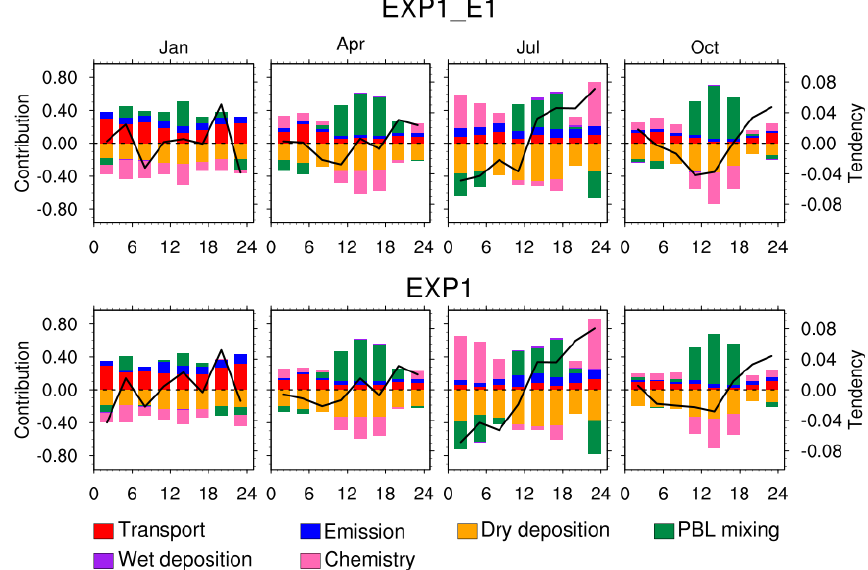
Figure 15. Relative contribution (normalized by monthly mean surface PM 2 . 5 concentrations for each month) to surface PM 2 . 5 concen- trations every 3h from individual processes (transport, emission, dry and wet deposition, PBL mixing, chemical production/loss) averaged over southern Anhui for January, April, July, and October of 2018 from experiments EXP1_E1 and EXP1. The 3-hourly relative tendency of surface PM 2 . 5 concentrations is also shown as the black